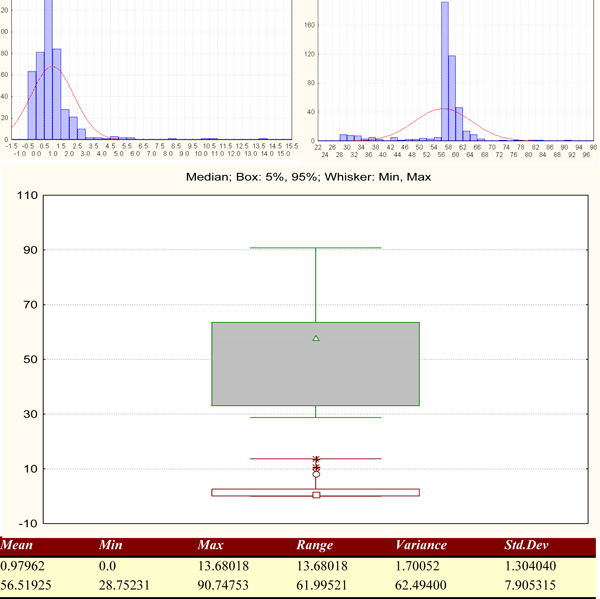
Plots and basic descriptive statistics of the local similarity function F(Wi) values for matching and non-matching pairs.